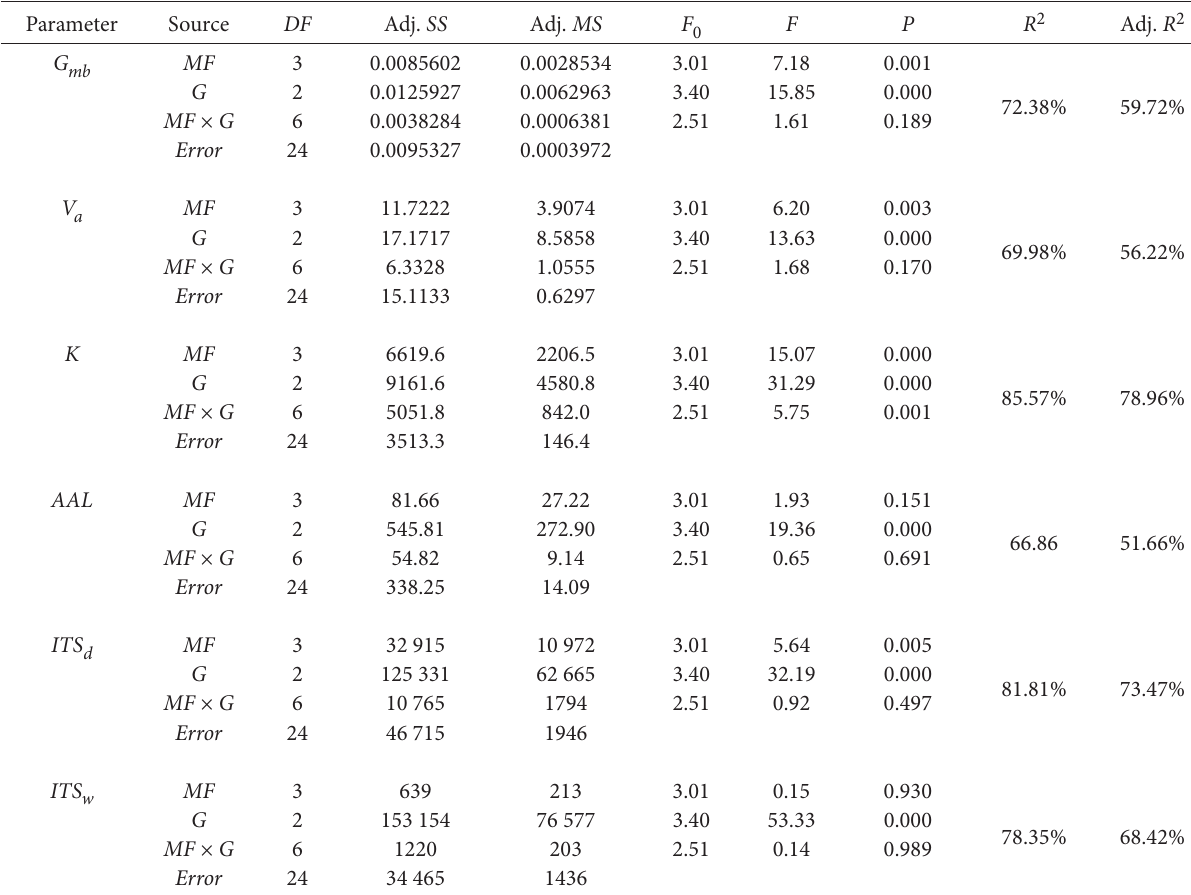
Table 5. F-statistics from ANOVA test Parameter Source DF Adj.